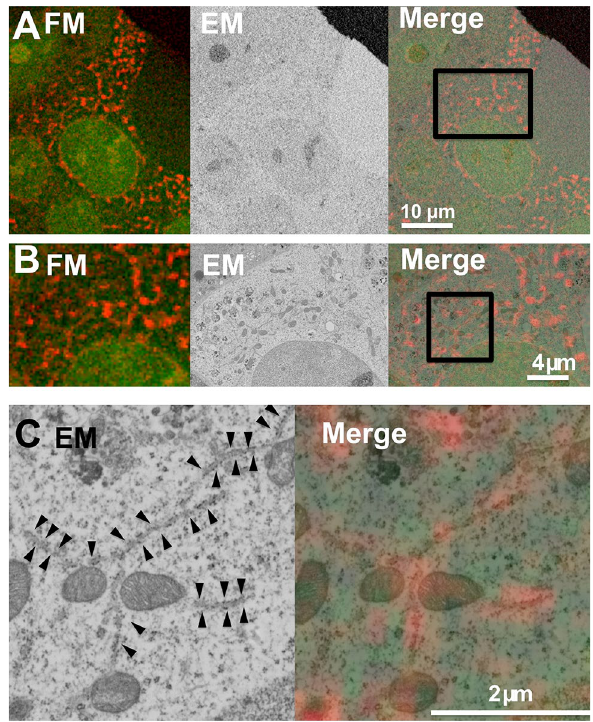
Figure 3. Two-color in-resin CLEM of nucleus and endoplasmic reticulum was performed using H2B- CoGFPv0 and mCherry2-ER. Thin section (100 nm) of Epon-embedded cells expressing H2B-CoGFPv0 (green pseudo color) and mCherry2-ER (red pseudo color) was prepared. Fluorescent images (FM) and electron microscopic images (EM) were obtained as described in Fig. 2. The “Merge” is a merged image of the fluorescence image (FM) with an electron microscopic image (EM). The images in ( B ) and ( C ) indicate magnification of images corresponding to the boxed area in the Merge image in respective ( A ) and ( B ). Arrowheads in ( C ) indicate red fluorescence-positive rough endoplasmic